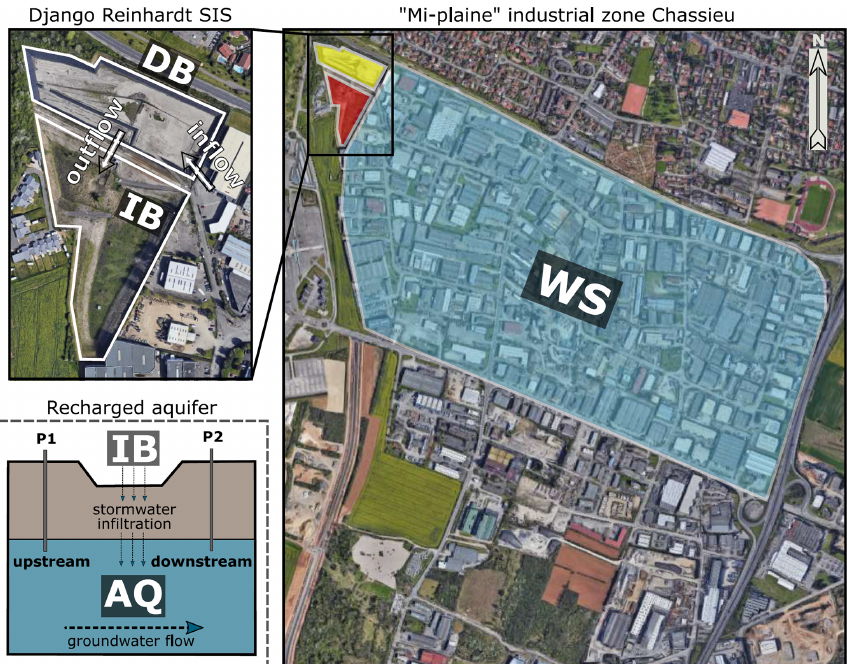
Figure 1. Scheme illustrating the trajectory of urban runoffs from the industrial watershed (WS) towards the stormwater infiltration system (SIS) investigated in this study. The urban watershed is located in Chassieu (France). The SIS is made of a detention basin (DB) and an infiltration basin (IB) and is connected to the Lyon 200km 2 east aquifer (AQ). (Map data: © Google and Maxar